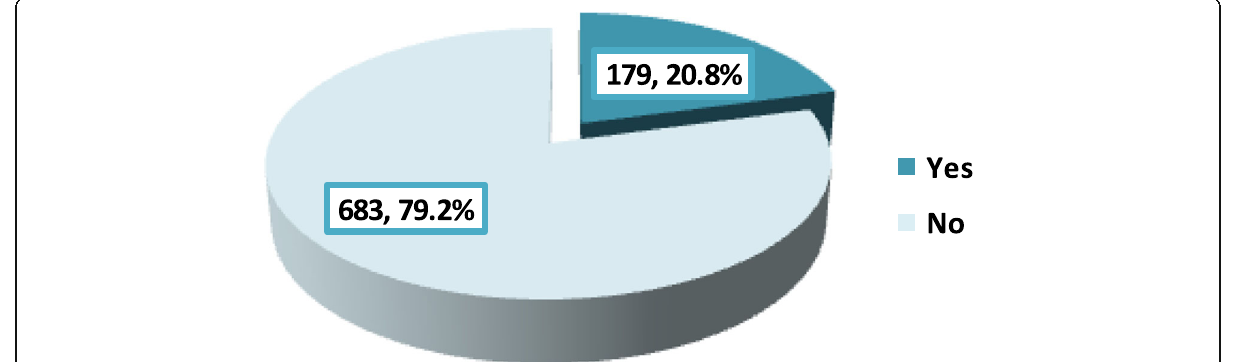
Fig. 1 History of having a relative with Alzheimer ’ s disease among the